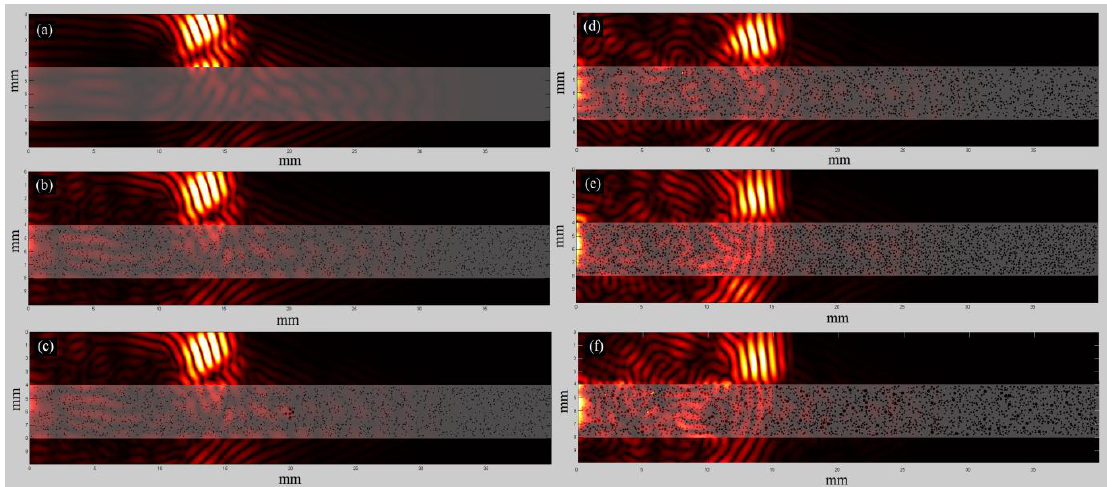
Figure 6. Snapshots of wave propagation for the first set of simulations using non-contact transducers for the excitation frequency of 1 MHz and time instant 10 μs for the cases: ( a ) B_Hom;